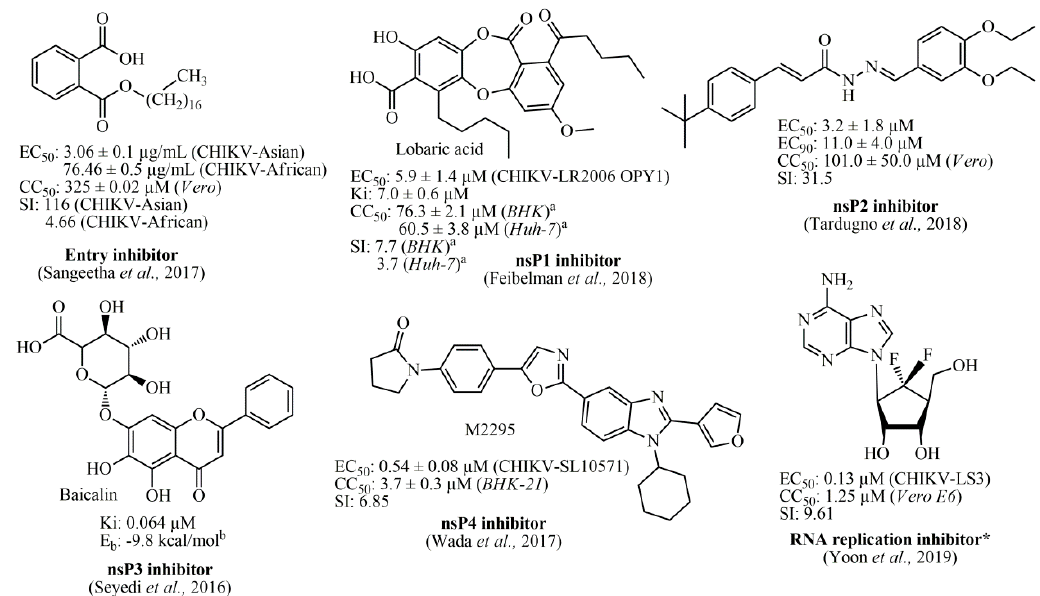
Figure 1. Best Chikungunya viral inhibitors reported in the literature and their corresponding targets. a : values obtained after 24 hours; b : Energy binding (E b ) value obtained by using Auto Dock Vina software; *: Fluorinated adenosine analog was reported as an RNA replication inhibitor, in which its antiviral activity was associated with an indirect effect on viral methyltransferase (MTase) activity through the inhibition of host S-adenosyl- L -homocysteine (SAH) hydrolase.